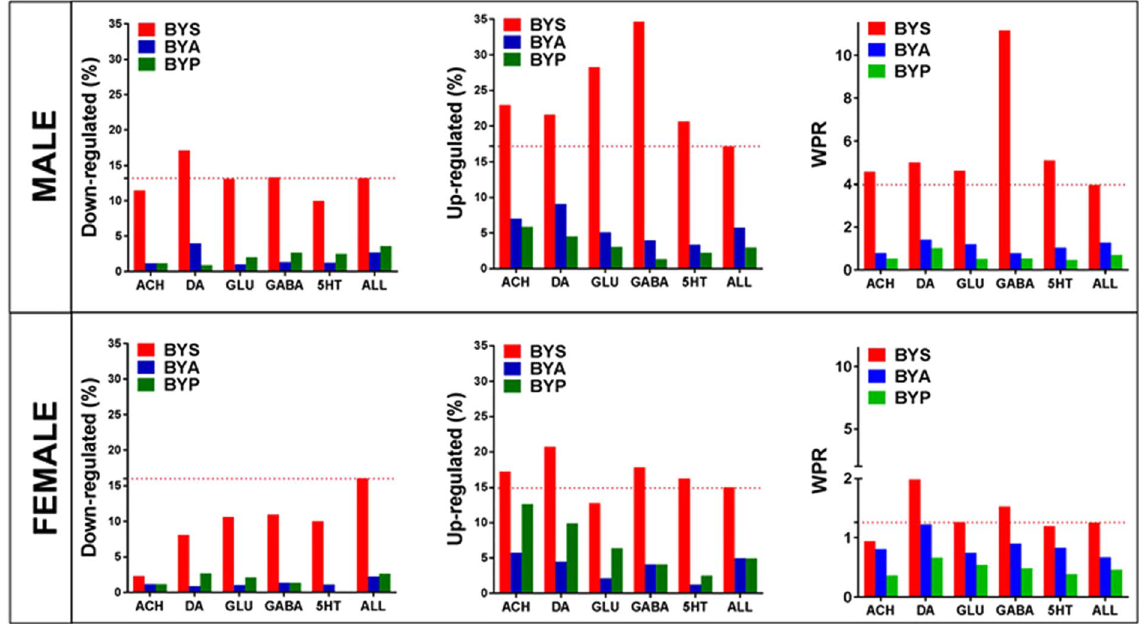
Figure 2. Transcriptomic alterations in response to NMDA-induced spasms in rats treated with ACTH (BYA), PMX53 (BYP) or just saline (BYS) compared to rats without IS (BNS). The alteration is presented as percentages of up-/down regulated genes and weighted pathway regulation (WPR) for the entire transcriptome (ALL) and each synapse